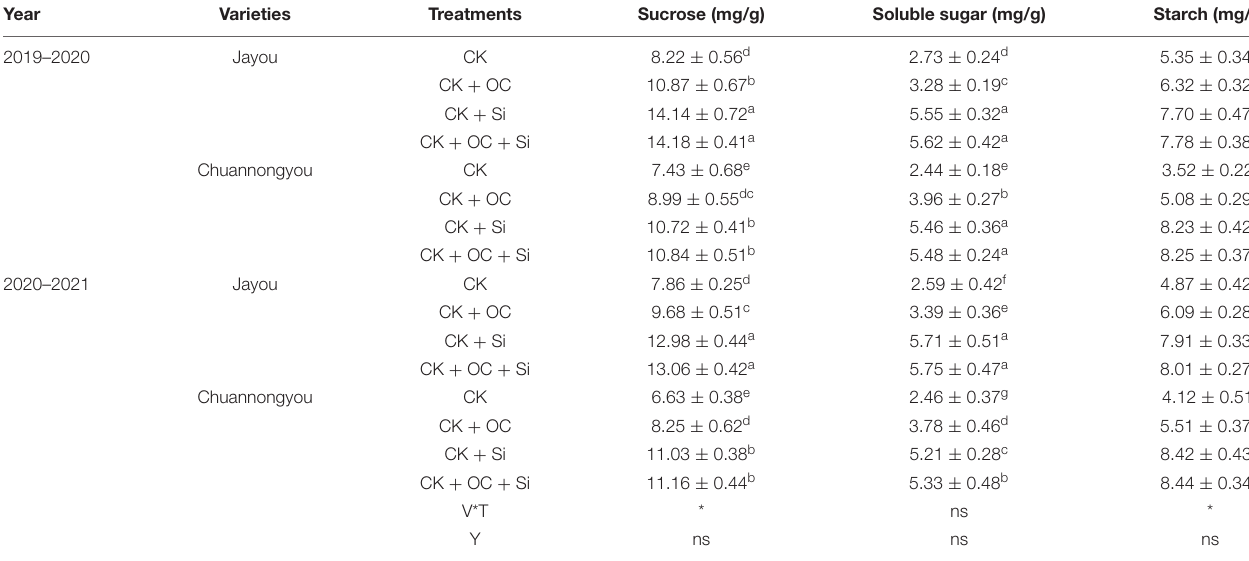
Different lower-case letters indicate significant differences among treatments at p ≤ 0.05 (LSD test) with the means (n = 3) of values. The CK, CK + OC, CK + Si, and CK + OC + Si represent the conventional fertilization, conventional + organic carbon fertilization, conventional + silicon fertilization treatment, and conventional + organic carbon + silicon fertilization treatment. V, T, and Y represent the variety, treatment, and year, while ∗ and ns indicate the significance and non-significance, respectively. TABLE 4 | Effects of different fertilizer treatments on lignin content of rapeseed stem. Year